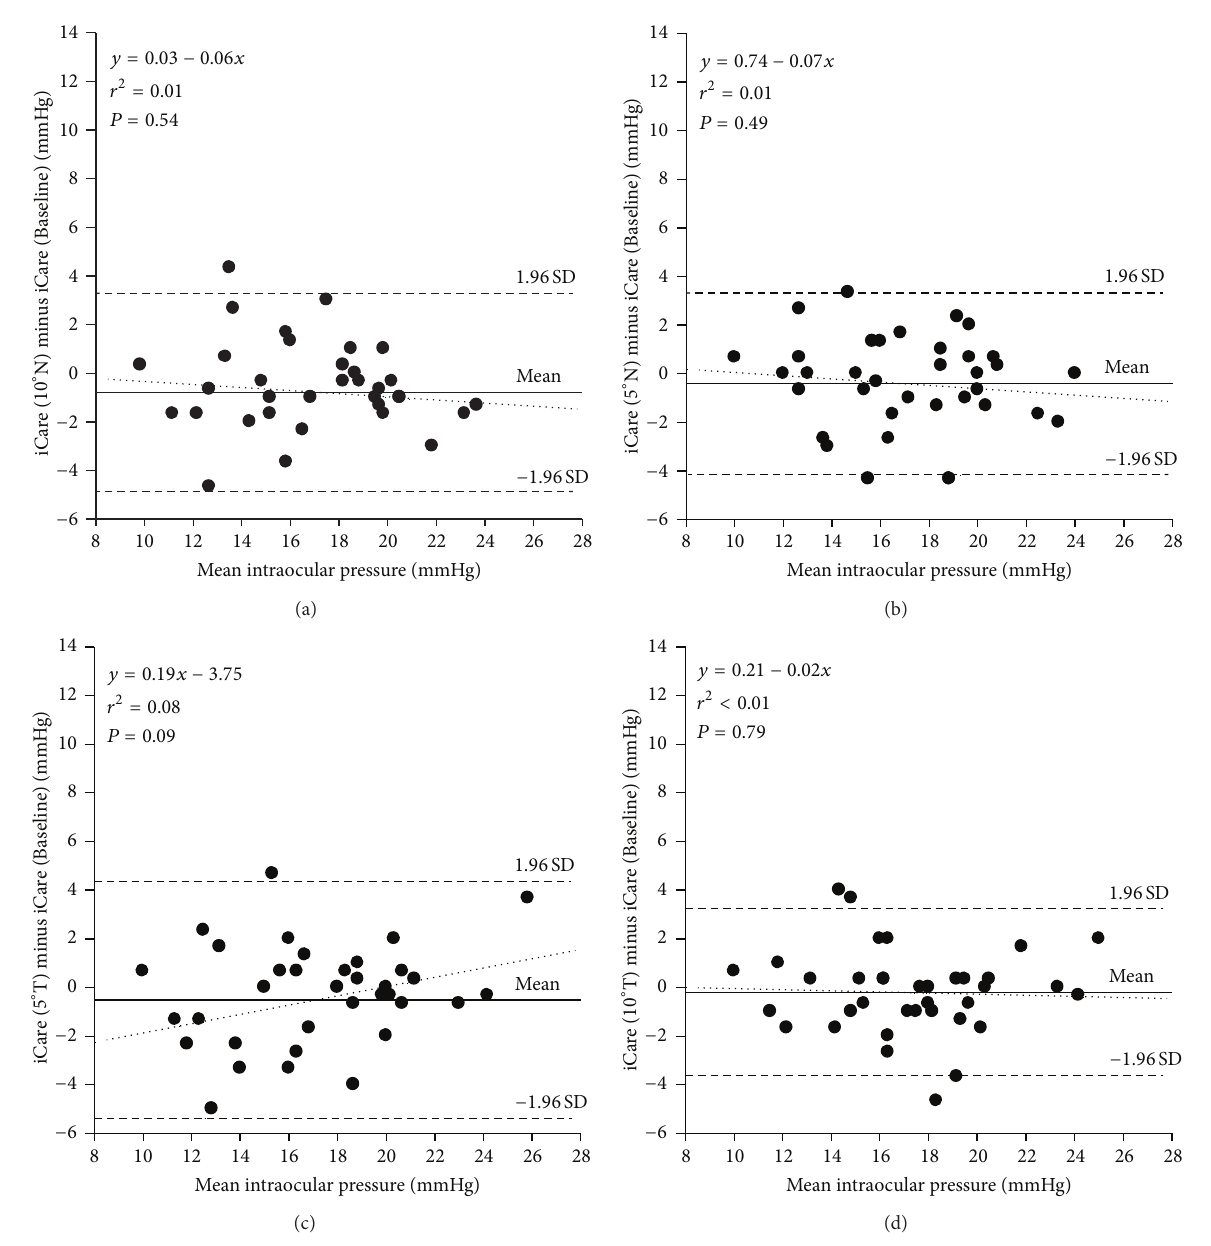
Figure 5: Difference versus mean plot illustrating the comparison between IOP measurements taken with the iCare tonometer at the baseline position (CC) and at specified angular deviations. (a) iCare tonometer probe was displaced by an angle of 10 degrees nasally. (b) iCare tonometer probe was displaced by an angle of 5 degrees nasally. (c) iCare tonometer probe was displaced by an angle of 5 degrees temporally. (d) iCare tonometer probe was displaced by an angle of 10 degrees temporally. The solid line represents the mean bias, and the dashed lines represent the 95% limits of agreement with the dotted regression line displayed. Angular deviation of the probe showed no significant correlation with measures at CC, in either of the two nasal and temporal